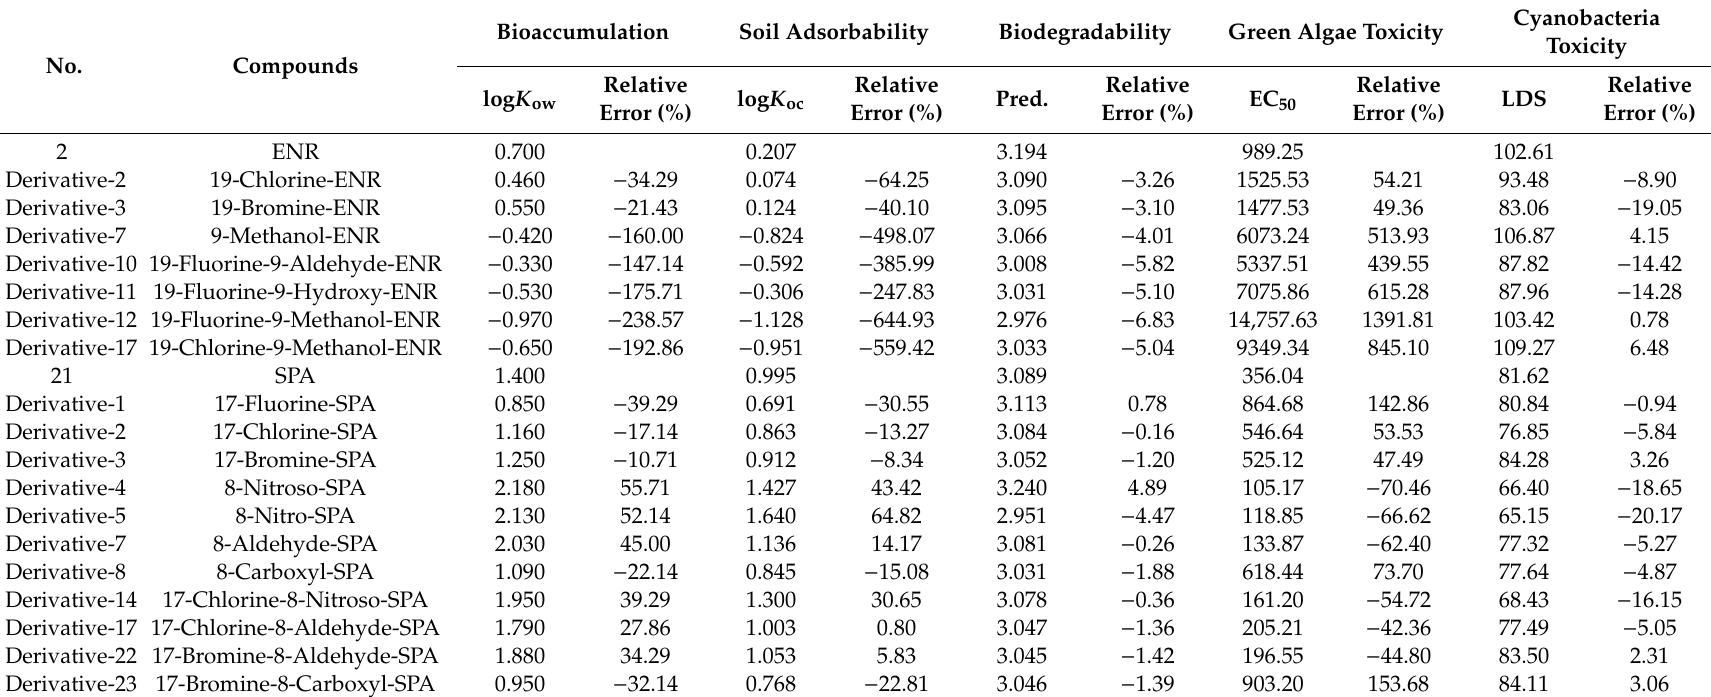
Table 5. Evaluation of environmental friendliness for ENR and SPA